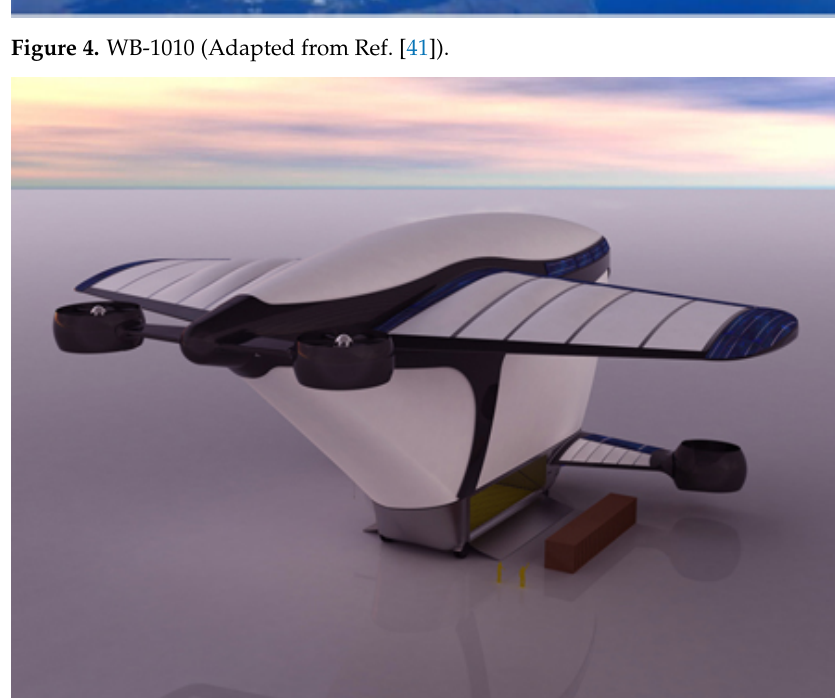
Figure 5. The Airship One (Adapted from Ref.